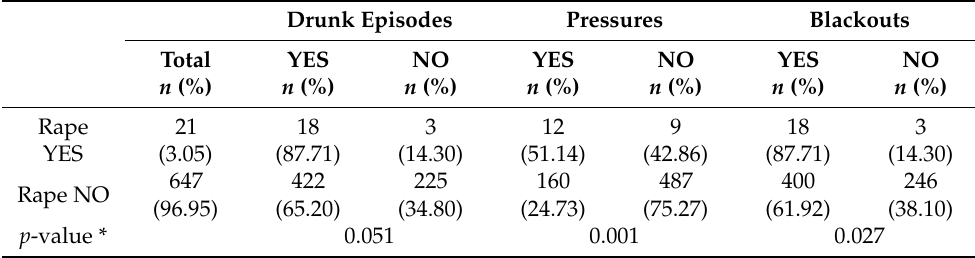
Table 4. Rape associated with drunk episodes, blackouts and pressures to consume ( n = 668).